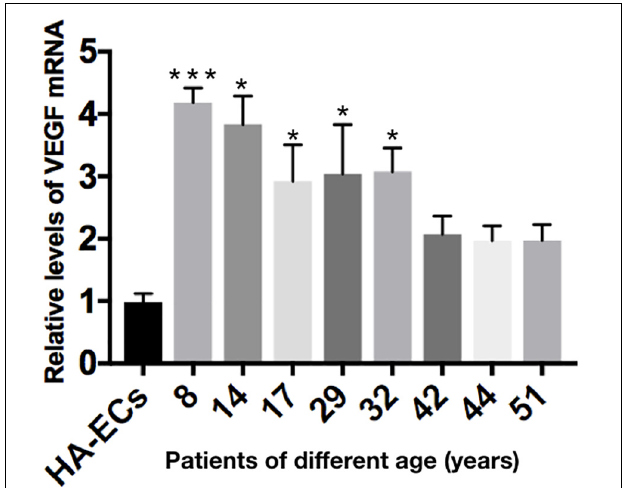
FIGURE 10 | mRNA expression of gene VEGF in HA-ECs and cAVM-ECs with different ages. Level of VEGF-A mRNA expression in the HA-ECs (0.98 ± 0.13) was lower than that in cAVM-ECs (8 years) (4.183 ± 0.238) and cAVM-ECs (14 years) (3.834 ± 0.451) (all ∗ p < 0.05). Level of VEGF-A mRNA expression in cAVM-ECs (17 years) was (2.92 ± 0.58), in cAVM-ECs (29 years) was (3.04 ± 0.79), in cAVM-ECs (32 years) was (3.08 ± 0.37), in cAVM-ECs (42 years) was (2.08 ± 0.28), in cAVM-ECs (44 years) was (1.97 ± 0.24), and in cAVM-ECs (51 years) was (1.97 ± 0.25), all of that were higher than that in the HA-ECs (0.98 ± 0.13) (all ∗ p <